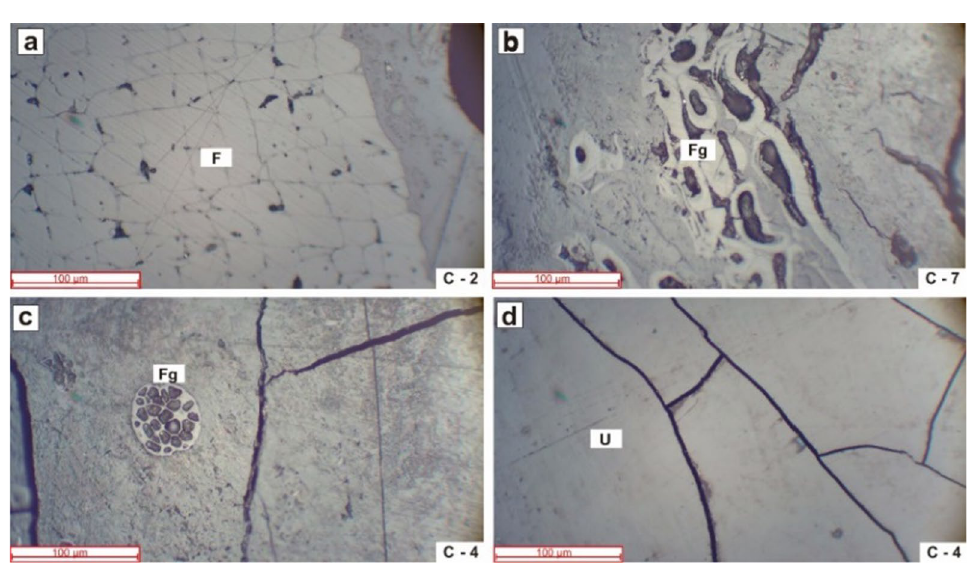
Fig. 3 Macerals in coal samples. ( a Fusinite (F); b Funginite (Fg) in sample C-7; c Funginite (Fg) in sample C-4; and d Ulminite (U); All pho- tomicrographs are taken under white light) Table 3 Petrographic analysis and ash yield of coal